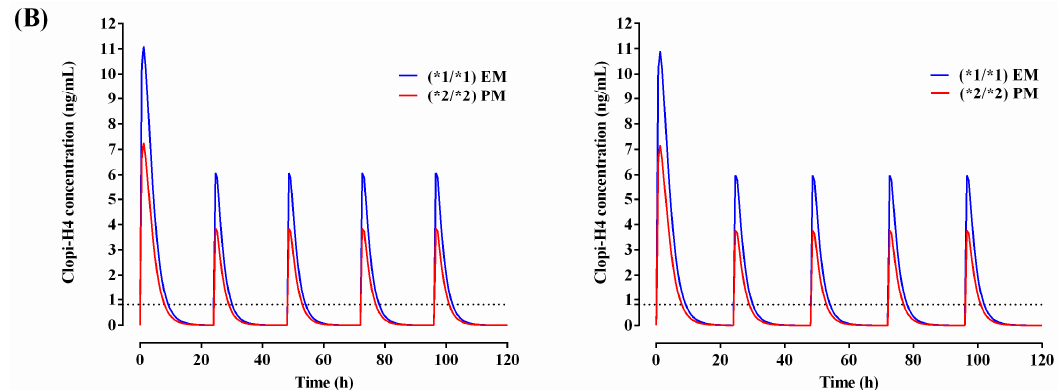
Figure 13. ( A ) impact of clopidogrel high dose regimen on clopi-H4 plasma C max in Malay (left panel) and Malaysian Chinese (right panel) subjects; ( B ) simulated mean plasma concentration–time profile of clopi-H4 in Malay (left panel) and Malaysian Chinese (right panel) subjects. An oral loading dose of 600 mg was administered on day 1, followed by daily doses of 150 mg for four days using the custom Malaysian (Malay and Malaysian Chinese) Simcyp population group ( n = 100), with dosing to populations of either all PM or all EM phenotypes. Solid plasma concentration lines represent mean predictions. Dashed horizontal lines represent the lower therapeutic limit for clopi-H4. Box and whisker plots represent maximum, 75th percentile, median, 25th percentile and minimum clopi-H4 C max .